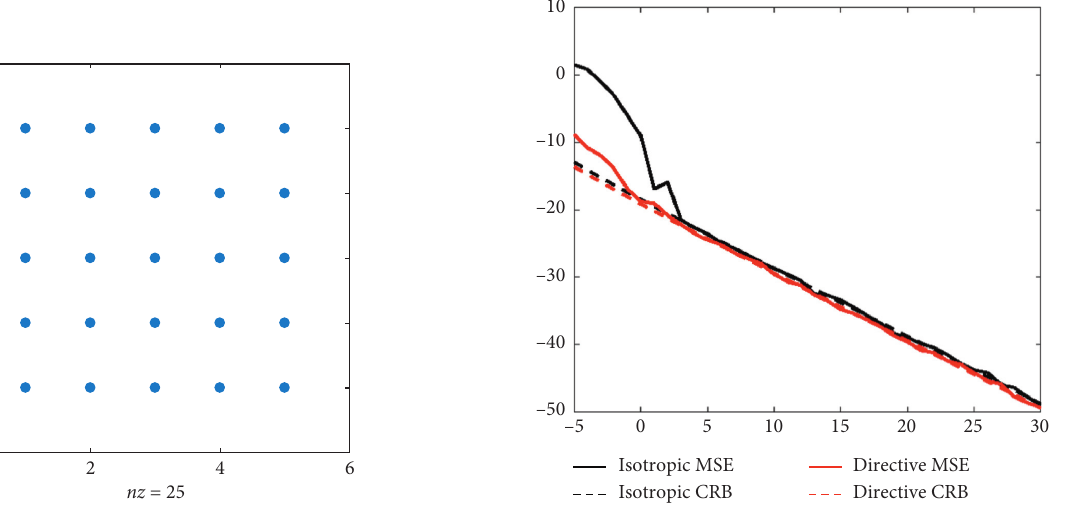
Figure 12: Total MSE and total CRB of type 3 and type 4